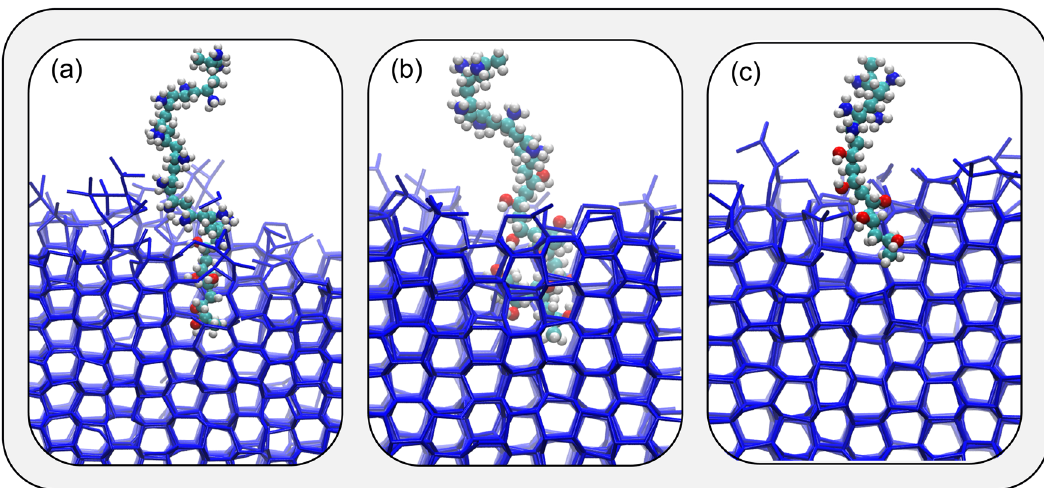
Fig. 9 Representative snapshots of IRI-active PVA copolymers binding to ice. a PVA 13 - b -PVAm 7 . b PVA 13 - b -PVAm 7 . c PVA 5 - b -PVAm 5 . The PVA segments can be identi fi ed via the hydroxyl groups (oxygen and hydrogen atoms are show in red and white, respectively), while the PVAm segments correspond to the amine functional groups (blue spheres repesents nitrogen atoms). The polymers typically bind to ice via the PVA segments only. Only water molecules belonging to the ice phase are